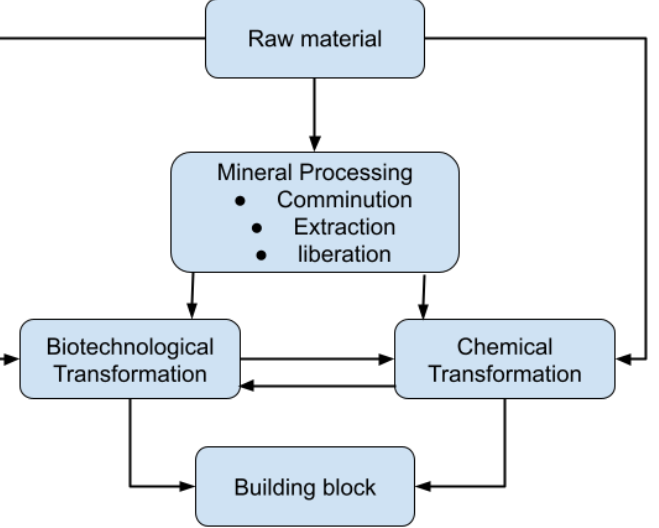
Figure 1. The typical process chain for renewables [20]. Many of the steps in this process chain are similar to the steps in conventional mineral